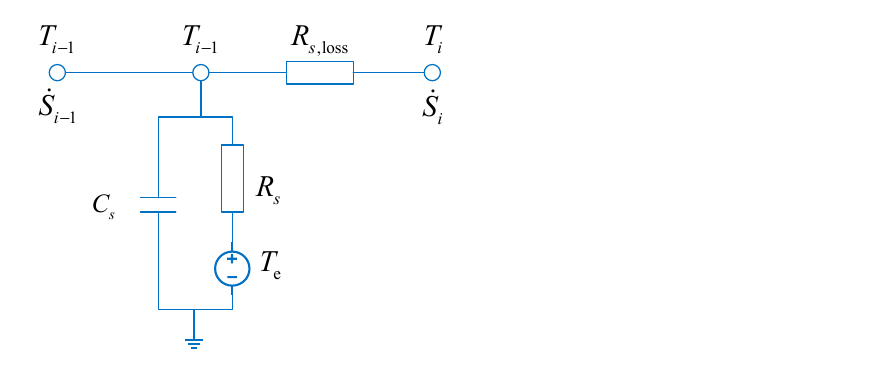
Figure 6. Convective equivalent model of entropy transport in unsteady state.